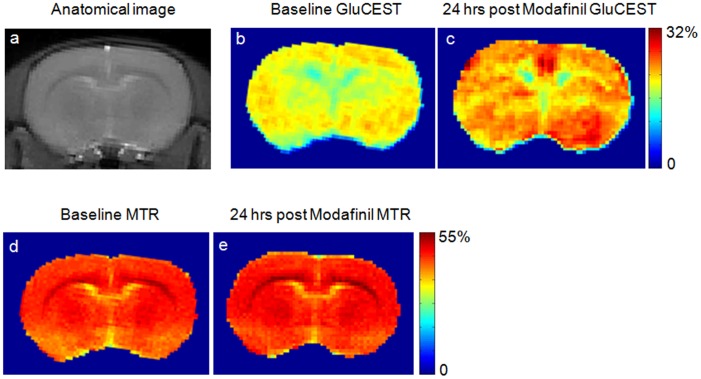
GluCEST map of a healthy rat brain from one of the group 2 animals pre and 24 hours post Modafinil injection.(a) Anatomical brain image from one of the group 2 normal rat. (b, c) GluCEST maps show an increase in GluCEST contrast 24 hours post Modafinil administration. (d, e) Magnetization transfer ratio (MTR) maps show no observable change in MTR contrast 24 hours post Modafinil administration.